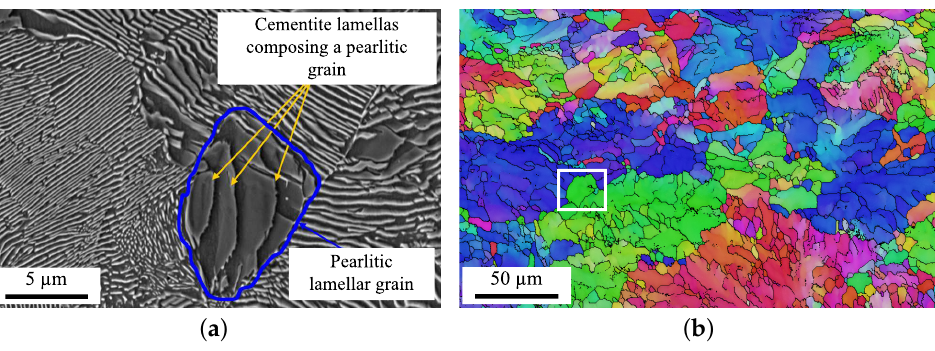
Figure 1. ( a ) SEM microstructure of the as-received structure and ( b ) EBSD IPFZ map of the as- received